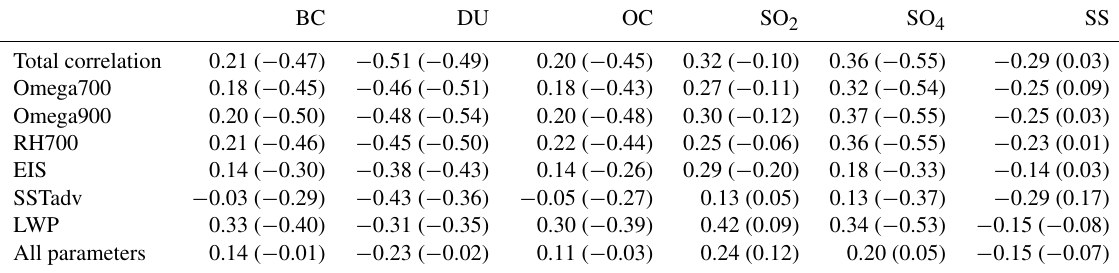
Table 3. Total correlations between the cloud albedo and different aerosol types, as well as the partial correlations to eliminate the influence of three meteorological parameters individually or simultaneously under different LWP conditions. The value above is under the condition of LWP ≤ 65gm − 2 . The value in parentheses is under the condition of 65gm − 2 < LWP ≤ 120gm − 2 . BC DU OC SO 2 SO 4 SS Total correlation 0.21 ( − 0.47) − 0.51 ( − 0.49) 0.20 ( − 0.45) 0.32 ( − 0.10) 0.36 ( − 0.55) − 0.29 (0.03) 0.18 ( − 0.45) − 0.46 ( − 0.51) 0.18 ( − 0.43)